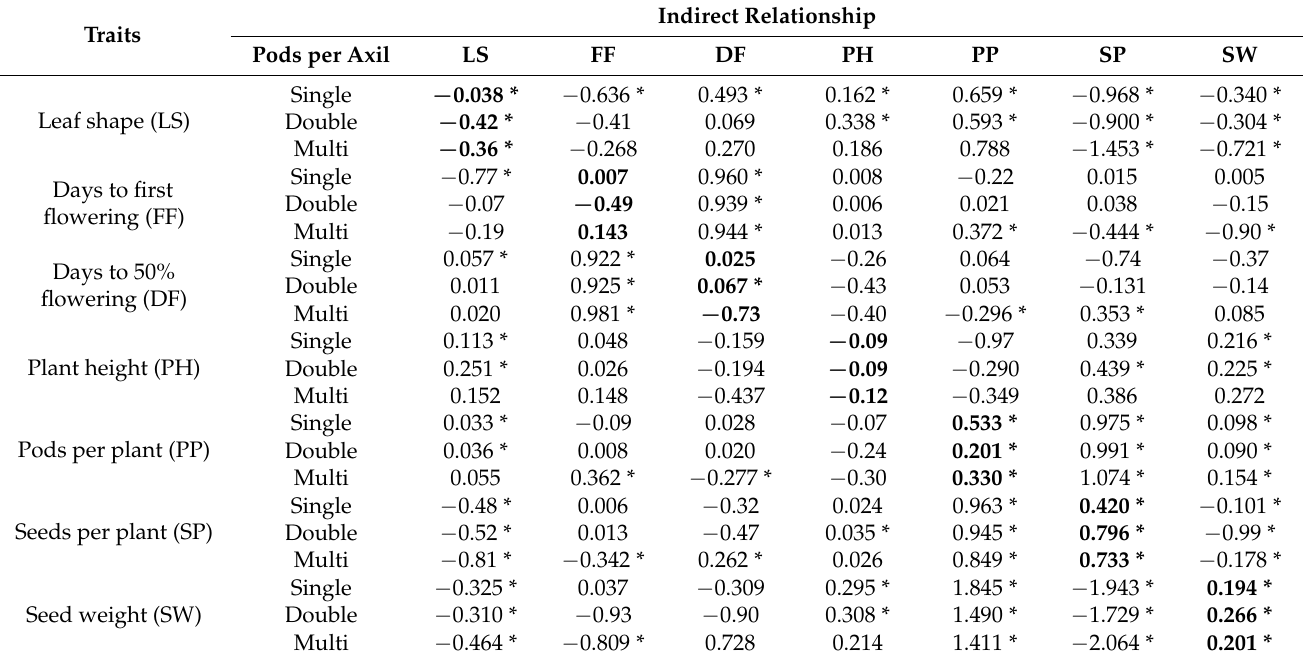
Table 3. Direct and indirect relationships among agro-morphological traits on seed yield over pods per axil.